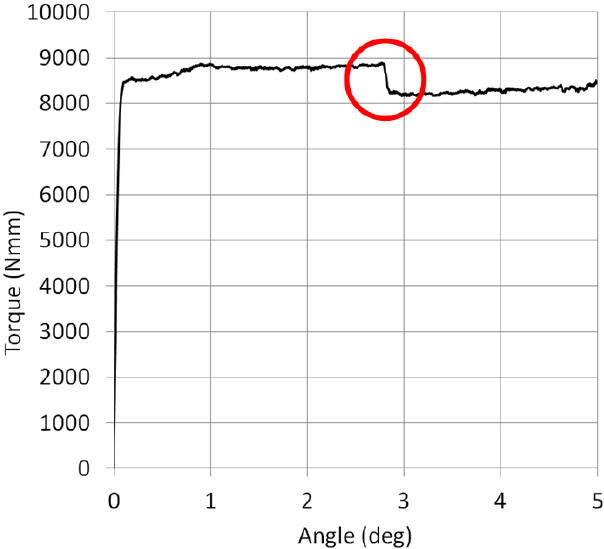
Figure 5: Typical raw experimental torque-angle curve. The red circle highlights the moment of the current turn